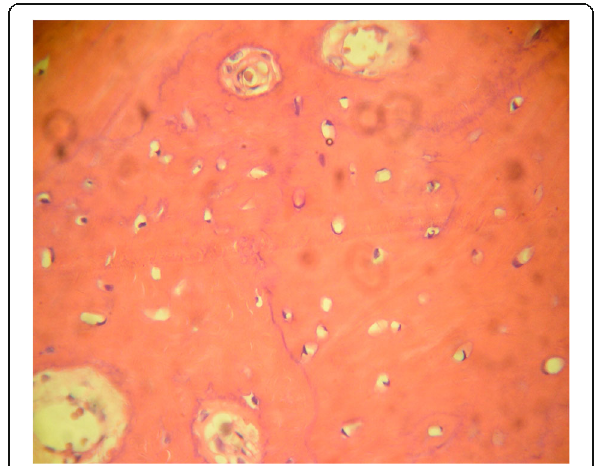
Fig. 5 The biopsy section showing the features of inflammatory fibroproliferative and osteogenic neoplasm